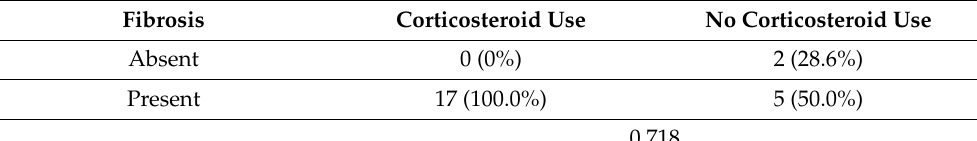
Table 3. Relation of Corticosteroid use and PF development. Fibrosis Corticosteroid Use No Corticosteroid Use Absent 0 (0%) 2 (28.6%) Present 17 (100.0%) 5 (50.0%)